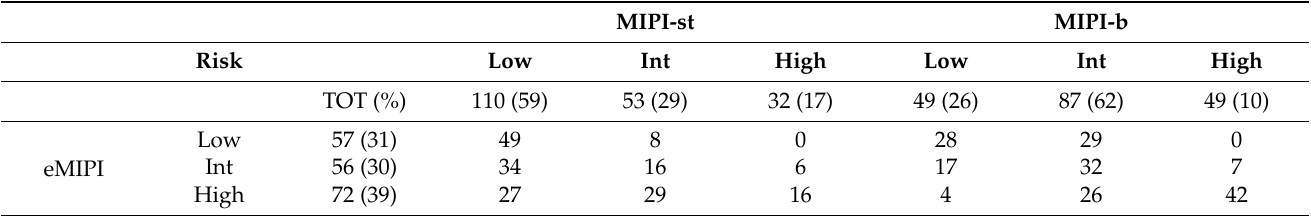
Table 2. Manual reduction of rules to obtain the smallest set that could correctly classify all the patients. Risk Formula Criteria Normal L and A symptoms, normal albumin, Low Ki-67, Low Low 1 LDH, and normal PLTs High 2 Abnormal albumin High 3 Normal albumin, high Ki-67, and normal PLTs High 4 Normal albumin, high Ki-67, presence of BMInf and B Sym Normal albumin, high Ki-67, presence of BMInf, normal High 5 Lymphocytes, and abnormal PLTs Normal albumin, Low Ki-67, presence of BMInf and B Sym, and High 6 elevated LDH Normal albumin, Low Ki-67, presence of BMInf and B Sym, Low High 7 LDH, normal Lymphocytes, and normal PLTs Int 8 Neither Low or High